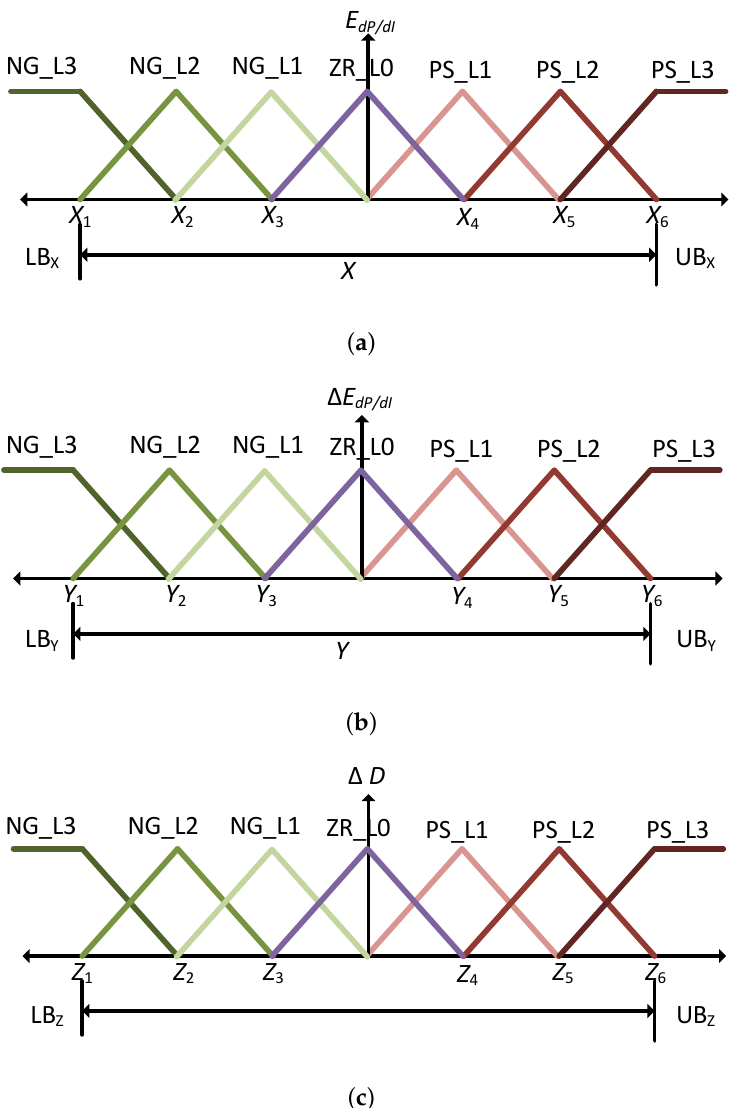
Figure 8. Input/output MFs with a seven level design; ( a ) Input E ( k ) ; ( b ) Input ∆ E ( k ) ; ( c ) Output ∆ D ( k )